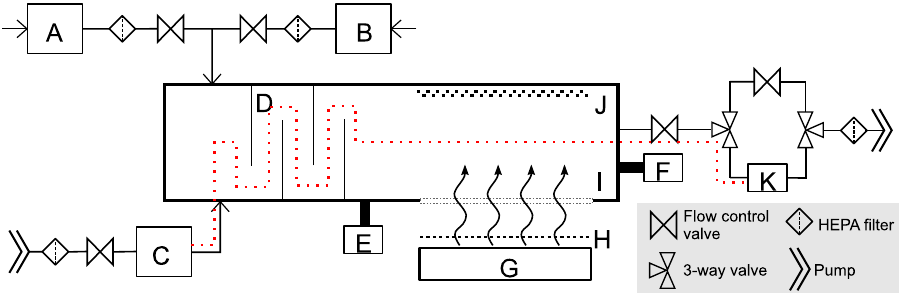
Figure 3. Schematic diagram of the custom UV irradiation chamber. The chamber is depicted in a top down view. Components of the setup include: water bubbler for humidified air input (A), a desiccator for dry air input (B), a nebulizer (C), baffles (D), an RH and temperature meter (E), a particle sizer (F), far-UVC lamps (G), band pass filters (H), a far-UVC transmitting plastic window (I), a reflective aluminum surface (J), and a BioSampler (K). Pumps are used to pressurize the nebulizer for aerosol generation and to control flow through the system. Flow control valves allow adjustments through the system. HEPA filters are included on all air inputs and outputs. A set of three way valves controls flow to or around the BioSampler. The vertically stacked lamps are directed at the window in the side of the chamber to expose the aerosols passing horizontally. The additional films to uniformly decrease the dose were placed between the filters and the window. The path of the aerosolized virus within the system during sampling is indicated with the red dotted